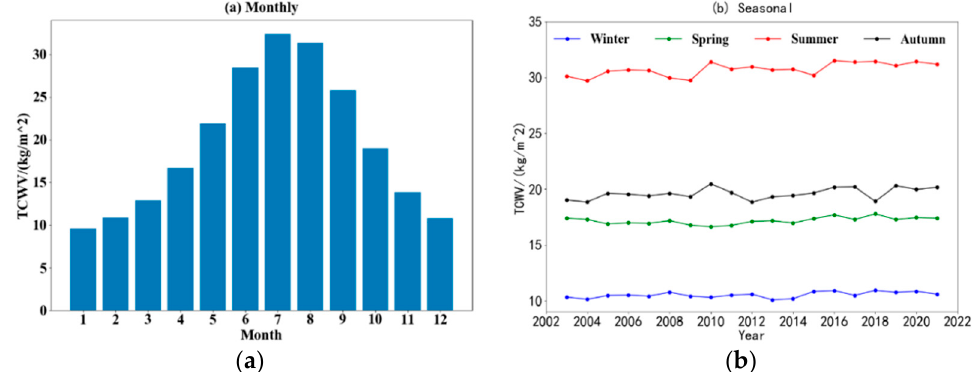
Figure 5. Monthly and seasonal variation of TCWV in China (2003–2021). ( a ) Monthly. ( b )